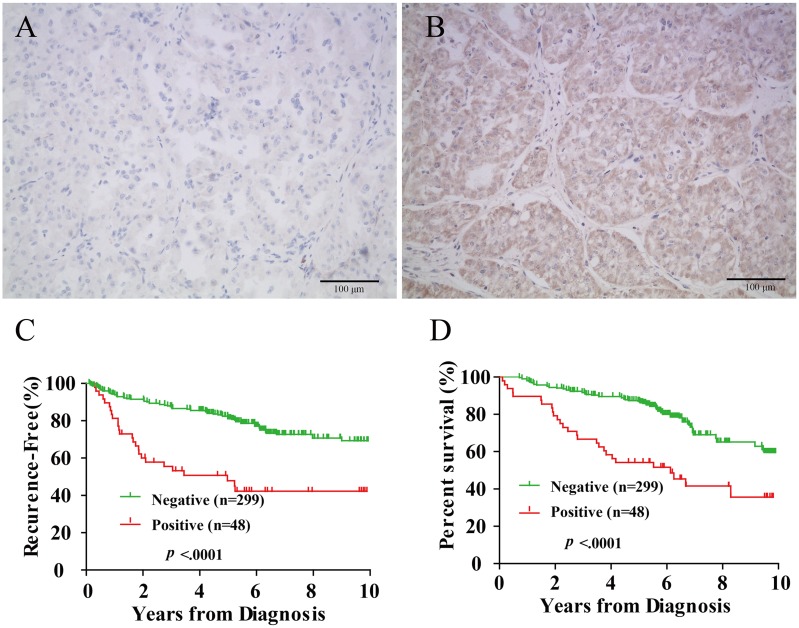
IMP3 expression in localized clear cell renal cell carcinoma and Kaplan-Meier survival analyses.A-B: Representative IMP3 immunostaining: negative (A, n = 299), positive (B, n = 48) immunoreactivity in localized CCRCC on tissue array. C-D: Kaplan-Meier survival analyses of CCRCC patients. Correlation of negative (n = 299) and positive IMP3 expression (n = 48) with recurrence free survival (C) and overall survival (D) were analyzed by univariate survival analysis (p<0.0001).